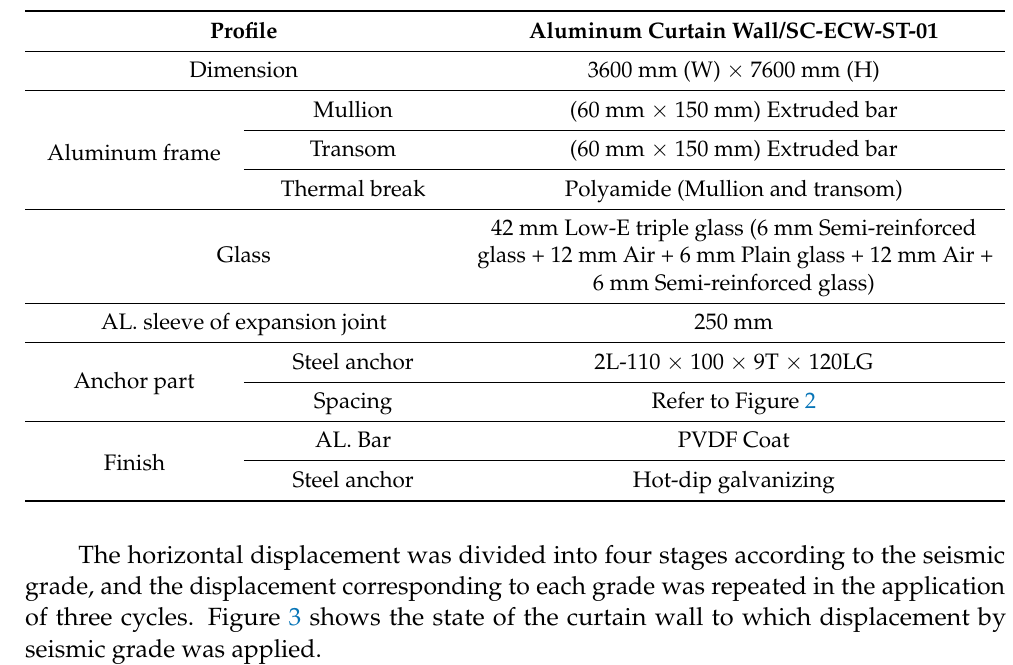
Figure 2. Conventional stick curtain wall system: ( a ) front view; ( b ) cross-section. Table 2. Designed member specifications of specimen components.